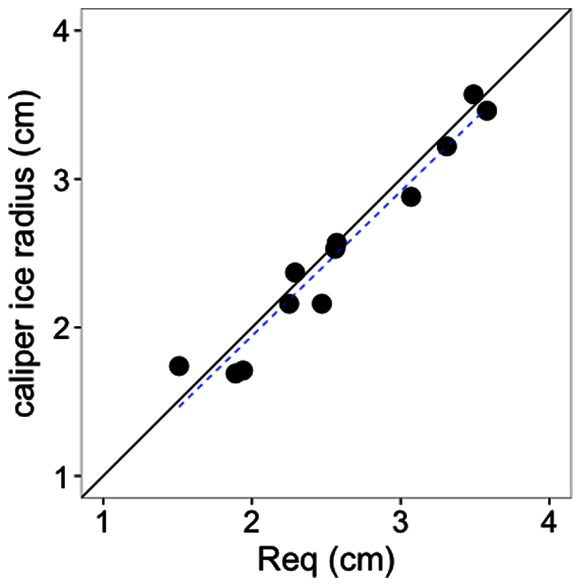
Relationship between equivalent radial ice thickness (Req) and caliper measurements of ice radial thickness.Req is estimated from the volume of ice (melt water) on branch samples with a given diameter and length. The solid line indicates a 1∶1 relationship and the dotted line the fitted relationship (y = −0.004+0.97x; F = 179.2, DF = 10, p<0.001, R2 = 0.95).